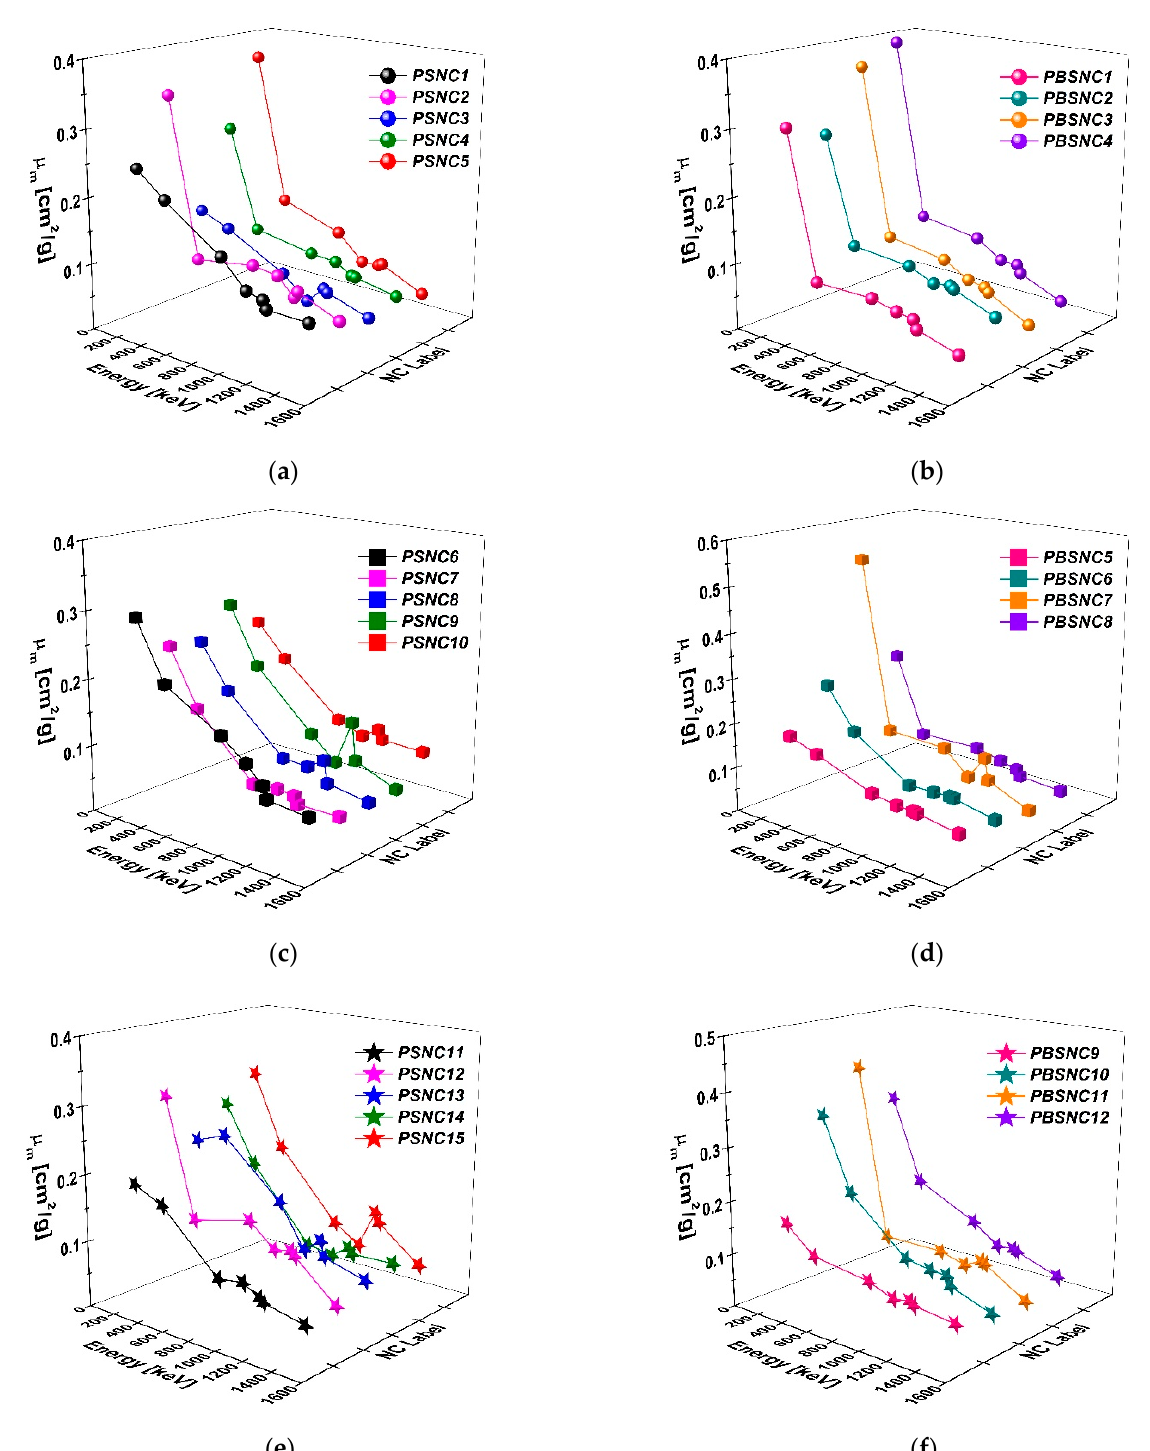
Figure 8. The µ m rates of the PS-b-PEG copolymers blended with the nanostructured SeO 2 and BN particles under a wide range of gamma irradiation energies: PSNC1, PSNC2, PSNC3, PSNC4, and PSNC5 ( a ); PBSNC1, PBSNC2, PBSNC3, and PBSNC4 ( b ); PSNC6, PSNC7, PSNC8, PSNC9, and PSNC10 ( c ); PBSNC5, PBSNC6, PBSNC7, and PBSNC8 ( d ); PSNC11, PSNC12, PSNC13, PSNC14, and PSNC15 ( e ); PBSNC9, PBSNC10, PBSNC11, and PBSNC12 ( f ). While the (cid:2020) (cid:3013) values of the PS-b-PEG copolymers blended with the nanostructured PbO particles change from 0.397 cm − 1 to 0.075 cm − 1 , the (cid:2020) (cid:3013) values of the PS-b-PEG (1000) copolymer blended with the nanostructured SeO 2 particles change from 0.557 cm − 1 to 0.103 cm − 1 (for 50% PS-b-PEG (1000) copolymer and 50% nanostructured particles) [12]. Addi- tionally, the (cid:2020) (cid:3013) values of the PS-b-PEG copolymers blended with the nanostructured PbO and BN particles change from 0.717 cm − 1 to 0.094 cm − 1 (for 15% PS-b-PEG (10,000) copoly- mer, 15% nanostructured BN, and 70% PbO particles) [12], while the (cid:2020) (cid:3013) values of the PS- b-PEG (10,000) copolymer blended with the nanostructured SeO 2 and BN particles change from 0.823 cm − 1 to 0.096 cm − 1 (for 15% PS-b-PEG (10,000) copolymer, 15% nanostructured BN, and 70% SeO 2 particles). Furthermore, the (cid:2020) (cid:3040) values of the PS-b-PEG copolymers blended with the nanostructured PbO particles change from 0.261 cm 2 /g to 0.049 cm 2 /g, while the (cid:2020) (cid:3040) values of the PS-b-PEG (1000) copolymer blended with the nanostructured SeO 2 particles change from 0.333 cm 2 /g to 0.062 cm 2 /g (for 50% PS-b-PEG (1000) copolymer and 50% nanostructured particles) [12]. In addition, the (cid:2020) (cid:3040) values of the PS-b-PEG co- polymers blended with the nanostructured PbO and BN particles change from 0.312 cm 2 /g to 0.041 cm 2 /g (for 15% PS-b-PEG (10,000) copolymer, 15% nanostructured BN, and 70% PbO particles) [12], and the (cid:2020) (cid:3040) values of the PS-b-PEG (10,000) copolymer blended with the nanostructured SeO 2 and BN particles change from 0.329 cm 2 /g to 0.039 cm 2 /g (for 15% PS-b-PEG (10,000) copolymer, 15% nanostructured BN, and 70% SeO 2 particles). According to these polymer-based results, nanostructured SeO 2 particles, as com- pared to nanostructured lead particles, are an efficient and high-value-added alternative for use in radiation shielding materials. We concluded that the gamma photons and the nanocomposite influence one another; that is, the developed nanocomposites attenuate the gamma rays, which could not penetrate our polymer-based nanomaterial. When the energy was increased, the gamma rays passed through the sample slightly more easily, illustrating that the (cid:2020) (cid:3013) and (cid:2020) (cid:3040) values were comparatively low in the high-energy gamma rays. According to the results of the nanocomposites we developed, nanocompo- sites with higher polymer content are more flexible and durable, while nanocomposites with a higher nanometal additive ratio have better gamma attenuation properties.